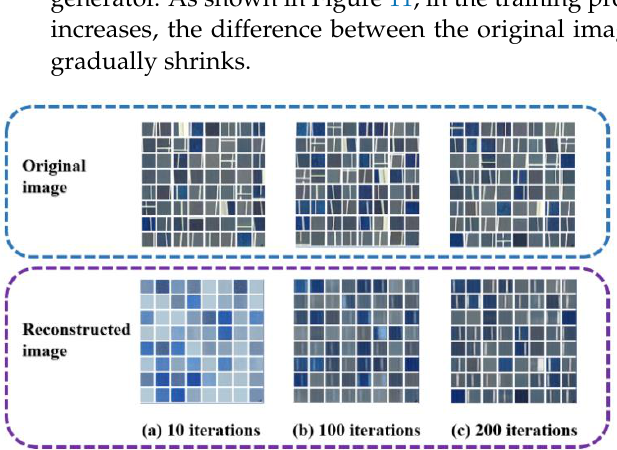
Figure 11. Original images and reconstructed images during training. ( a ) 10 iterations results; ( b ) 100 iterations results; ( c ) 200 iterations results.